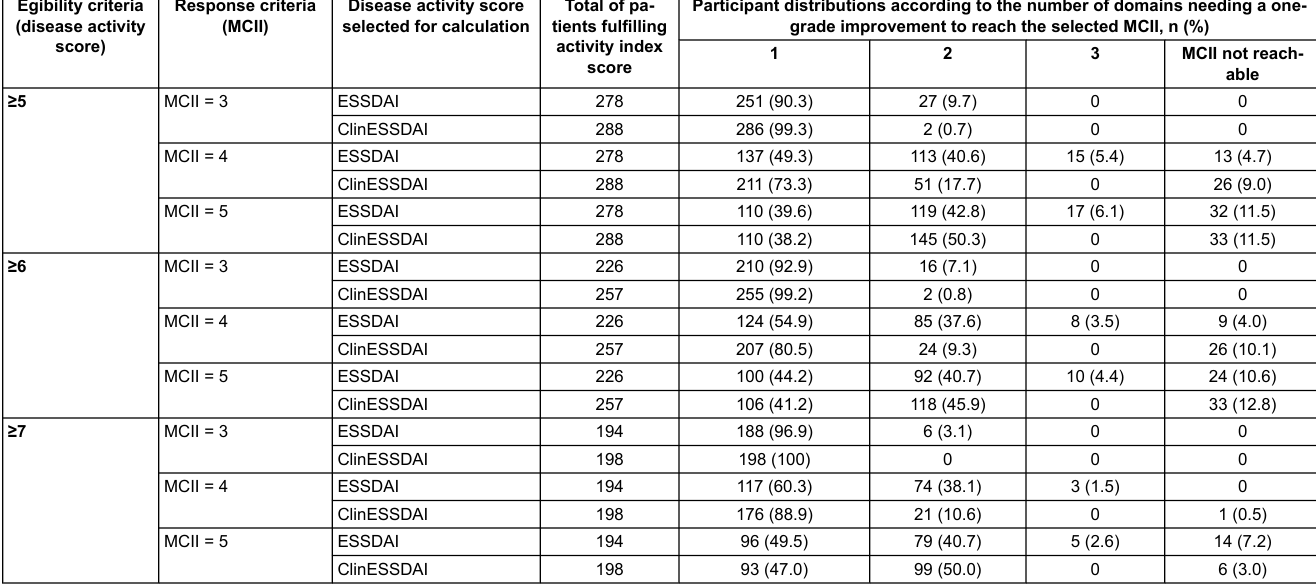
Table 4: Ability to improve: number of participants from the UKPSSR requiring a one grade improvement in 1, 2, or 3 of their active domains to reach the MCII value according to several MCII target values and disease activity